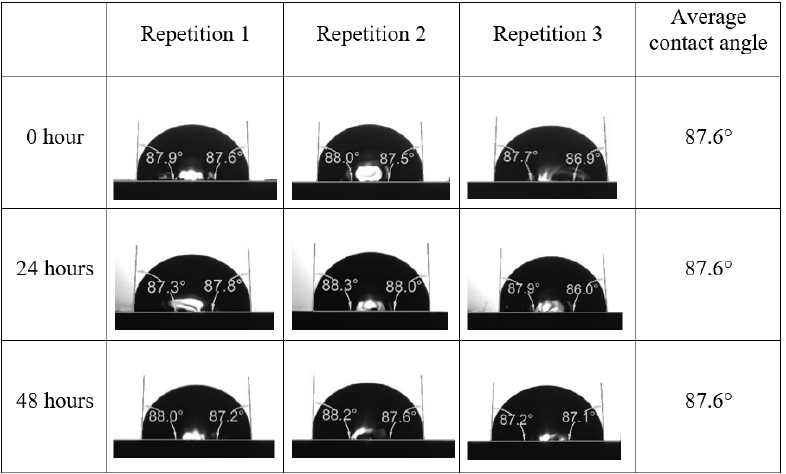
Figure A22. Dynamic Contact Angle Measurement Results for 75% Na 2 SO 4 + 25% KCl (3500 ppm).